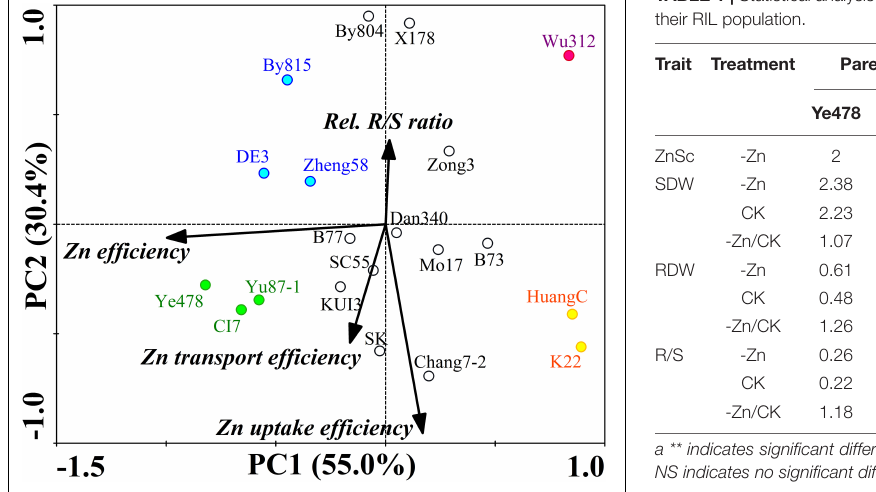
FIGURE 5 | Principal component analysis of ZE based on the shoot dry weight, relative R/S ratio efficiency, Zn uptake efficiency, and Zn transport efficiency (relative Zn transport) under the Zn deficiency of 20 maize inbred lines. Two principal components (PC1 and PC2) were extracted and accounted collectively for 85.4% of the variance. Dots represent the position of the 20 inbred lines determined by their values on the given principal component. The dots in green, blue, orange, and red represent four typical types of maize inbred lines differing in Zn deficiency tolerance. Black lines indicate vectors quantifying the magnitude and direction of a trait’s contribution to the principal component.